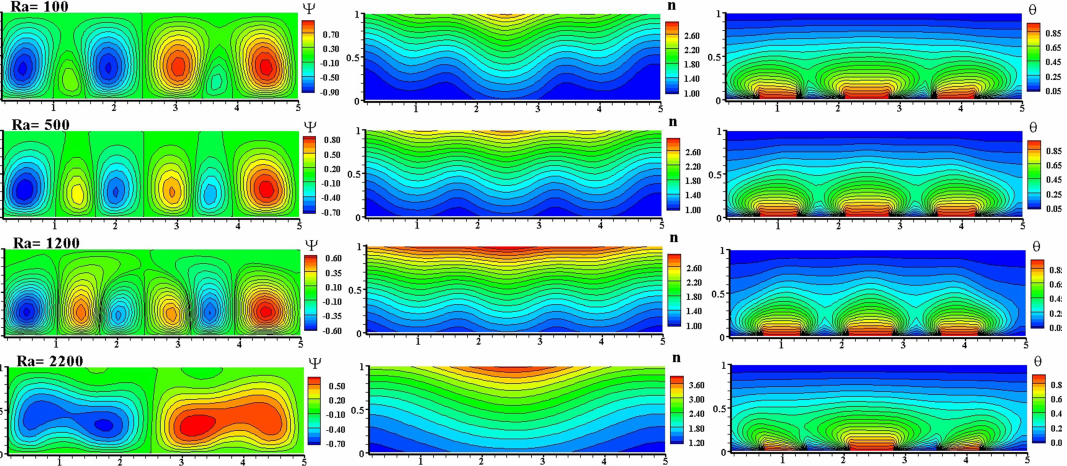
Figure 8. Case 6. From left to right, streamlines, microorganisms concentration and dimensionless temperature contours. For Sc = 1, Pe = 1, Ra T = 1708 and bioconvective Ra for 100, 500, 1200 and